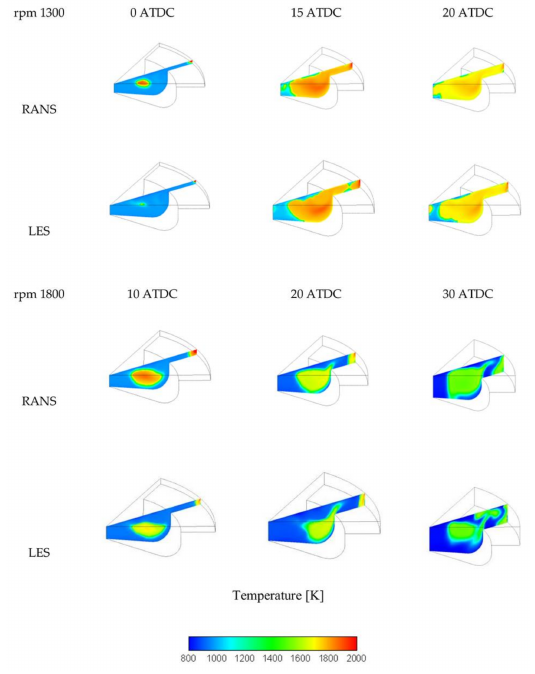
Figure 14. Comparison of LES and RANS model for cylinder temperature cut planes at 3 crank angles for 1300 rpm and 1800 rpm engine